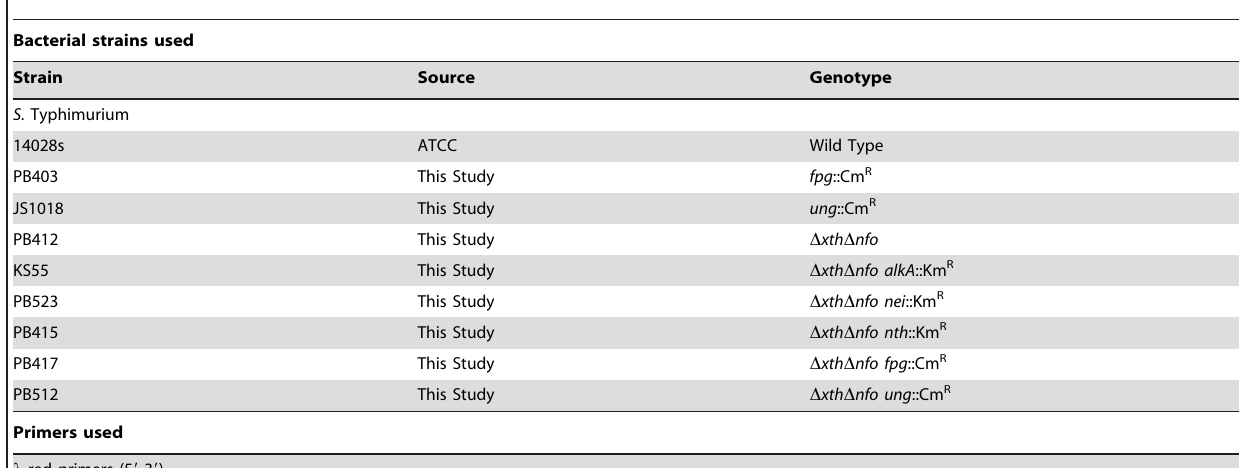
Table 2. Bacterial strains and DNA primers used in this study.